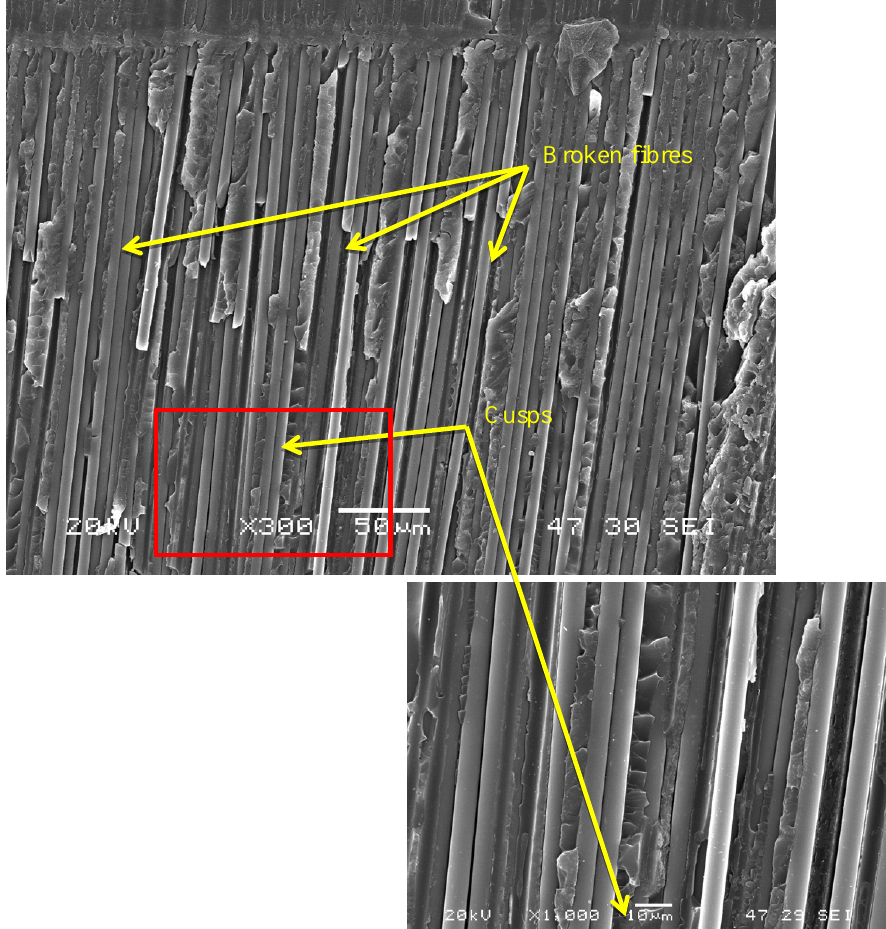
Figure 6. Presence of broken fibres and cusps in a region near the insert. Polymers 2019 , 11 , x FOR PEER REVIEW